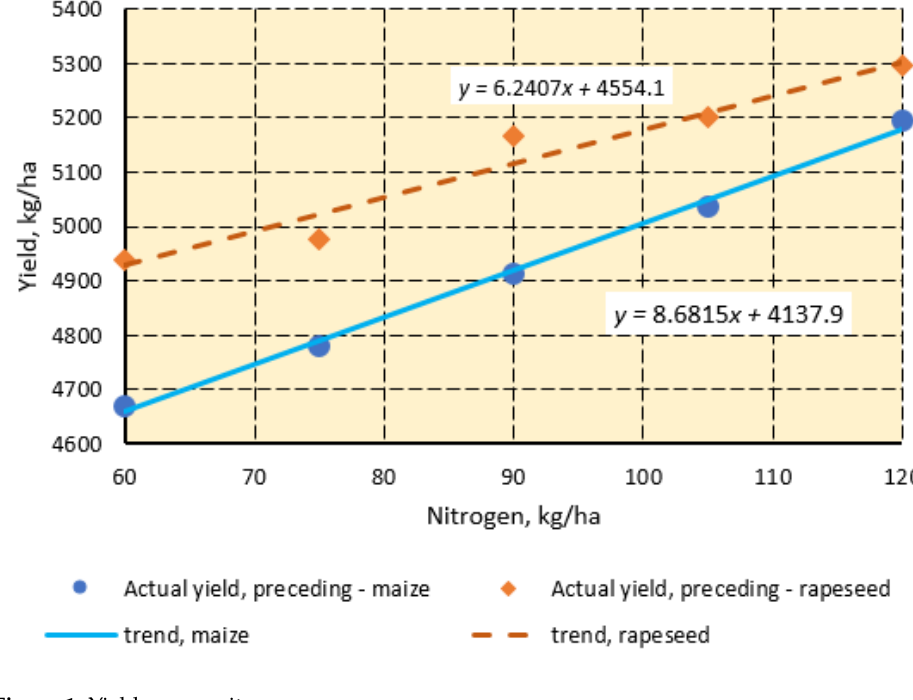
Figure 1. Yield versus nitrogen .